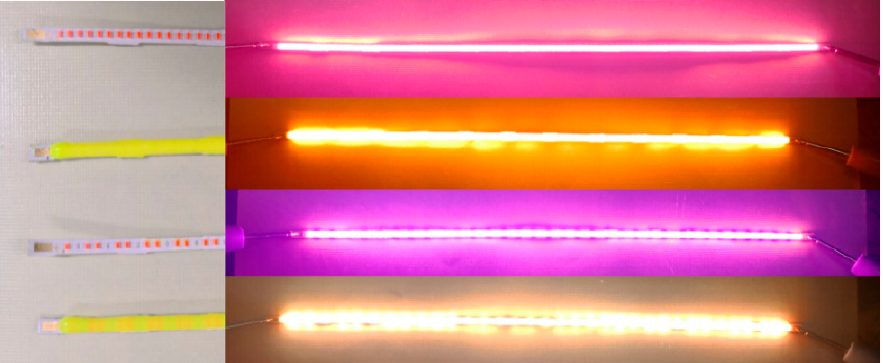
Figure 5. An actual image of the stacked type packaged filament.